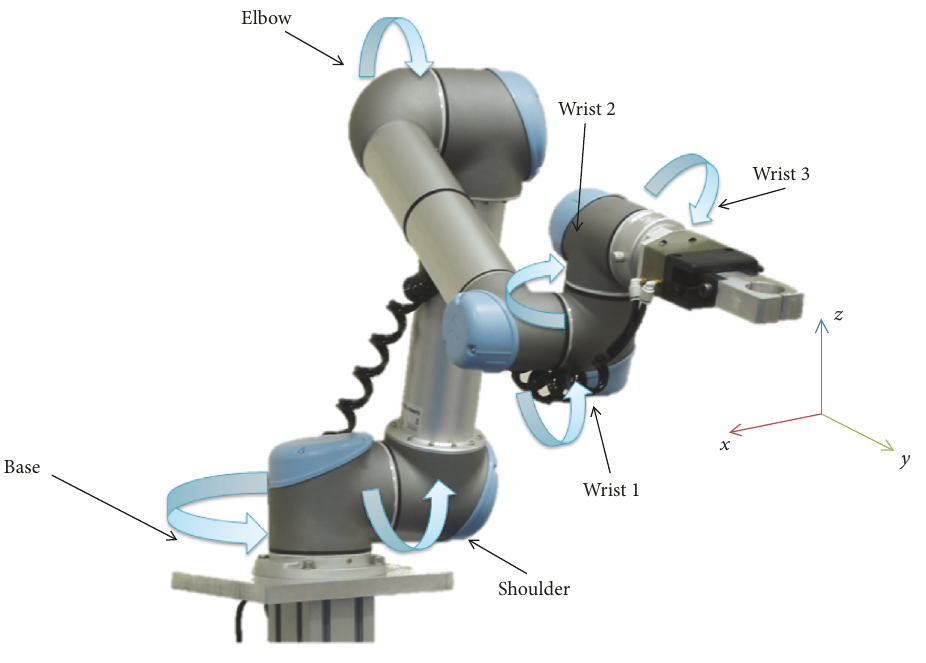
Figure 2: The Universal Robot UR5 has 6 dof which can be utilised with the gesture control system.